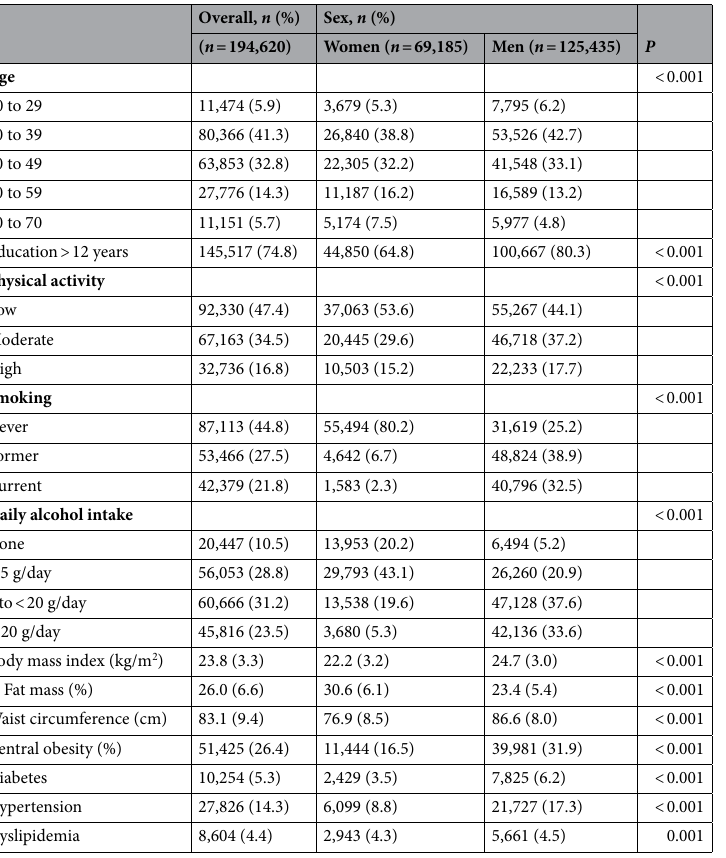
Table 1. Characteristics of study participants. Values in the Table are number (%) or mean